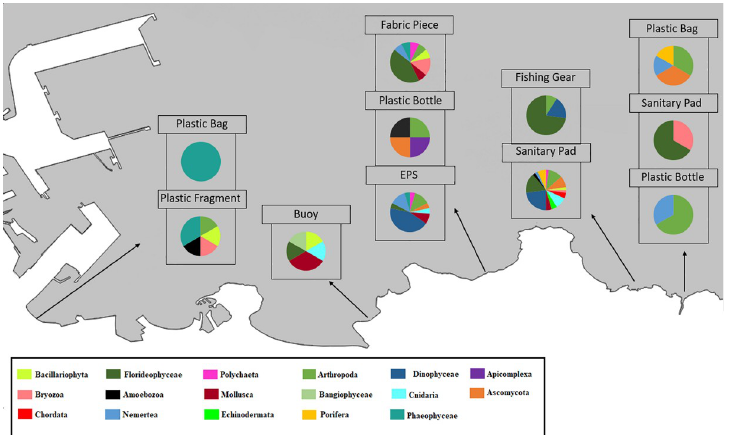
Fig 5. Composition of the main taxa found on each litter